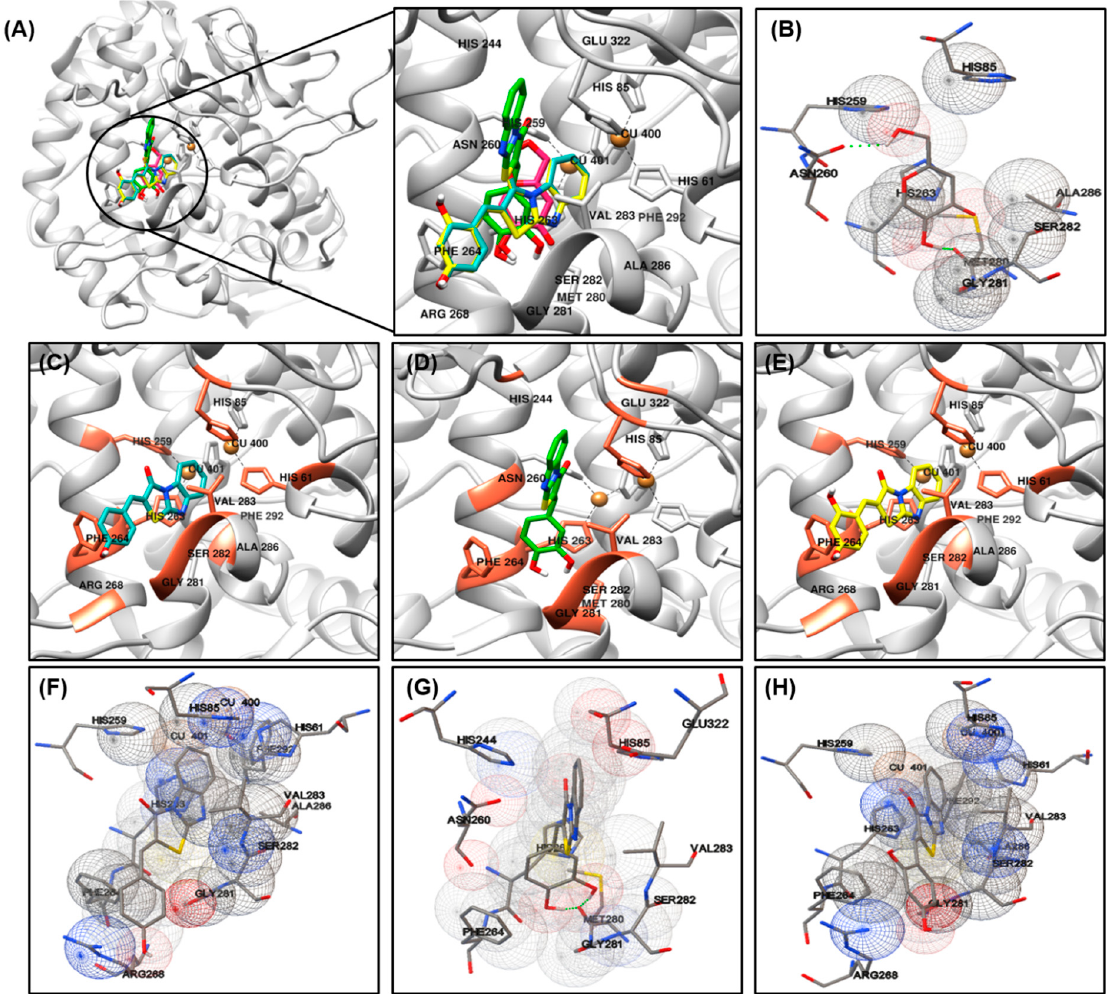
Figure 3. Molecular docking simulations of tyrosinase inhibition by the reference compound and compounds 1 (( C ), blue stick), 2 (( D ), green stick), and 3 (( E ), yellow stick) in the active site of Agaricus bisporus mushroom tyrosinase (PBD ID: 2Y9X) ( A ). The binding residues of kojic acid ( B ) and compounds 1 ( F ), 2 ( G ), and 3 ( H ) with tyrosinase were analyzed using the AutoDockTools software. Oxygen and nitrogen atoms are displayed in red and blue, respectively. Copper ions are shown in orange. Table 4. Docking energy and binding sites of compounds 1 – 3 against mushroom tyrosinase (PDB ID: 2Y9X), as performed using the AutoDock 4.2 and AutoDock Vina